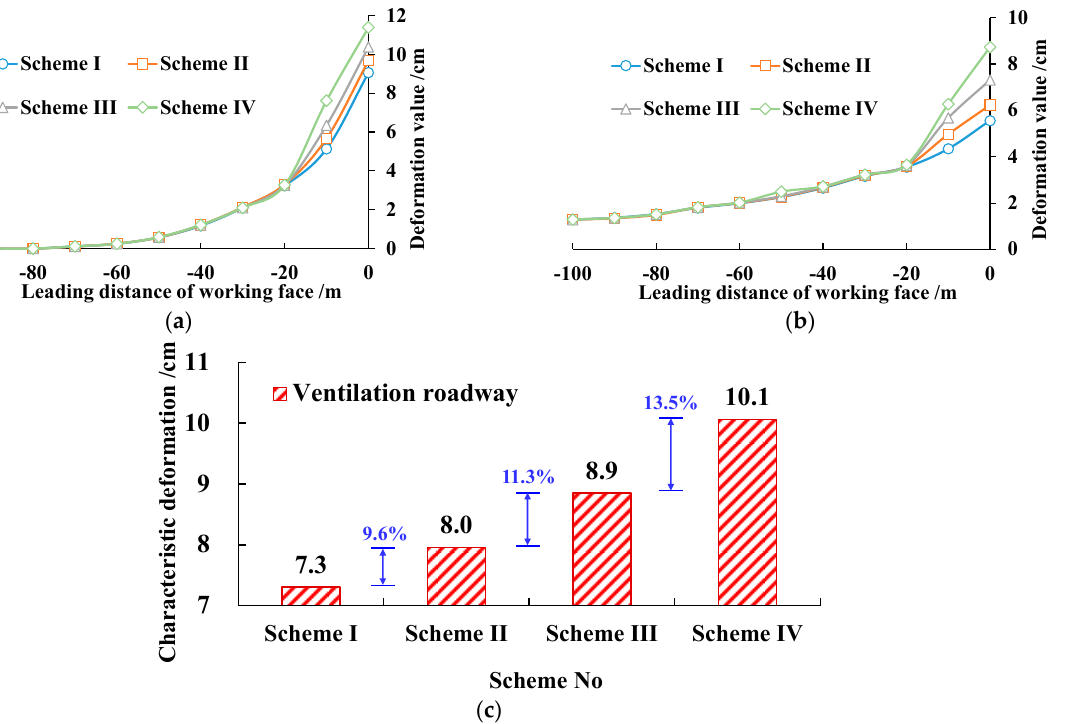
Figure 7. Comparison of the surrounding rock deformation of the ventilation roadway in each scheme. ( a ) Roof and floor convergence deformation. ( b ) Convergence deformation of the two sides. ( c ) Comparison of the quantitative evaluation index of each scheme.